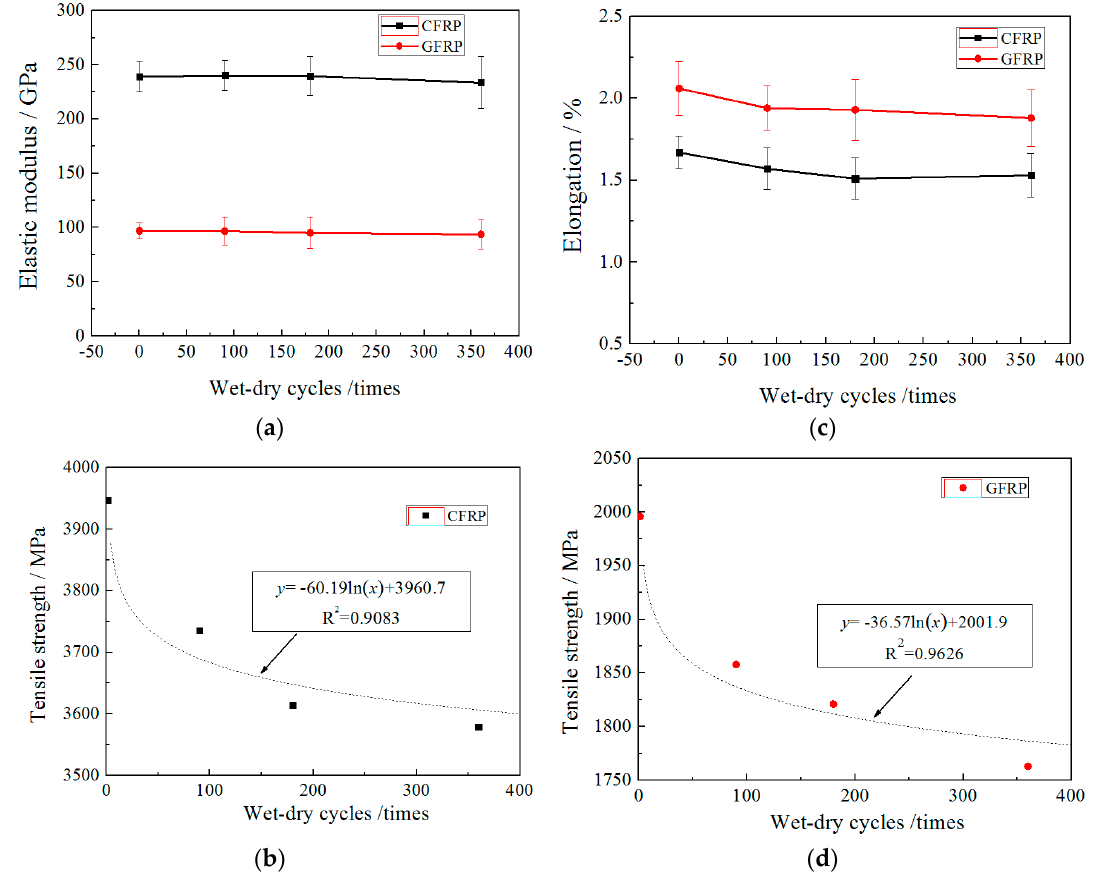
Figure 3. The properties of FRP after wet-dry cycle exposure: ( a ) Elastic modulus; ( b ) elongation; ( c ) tensile strength of CFRP, and ( d ) tensile strength of GFRP.